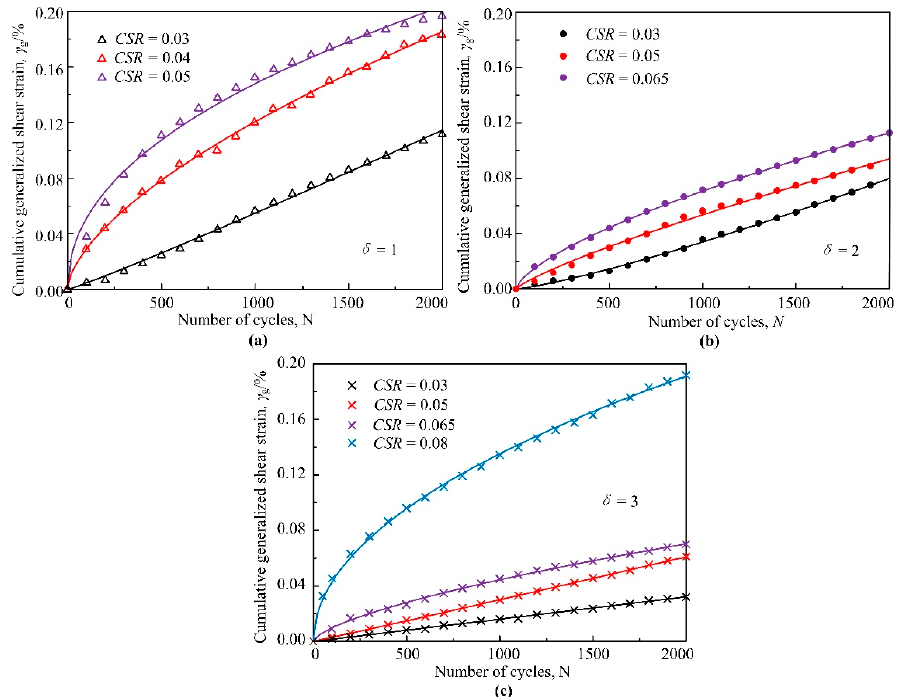
Figure 7. ( a – c ) Relationship between cumulative generalized shear strain and number of cycles under the same δ .